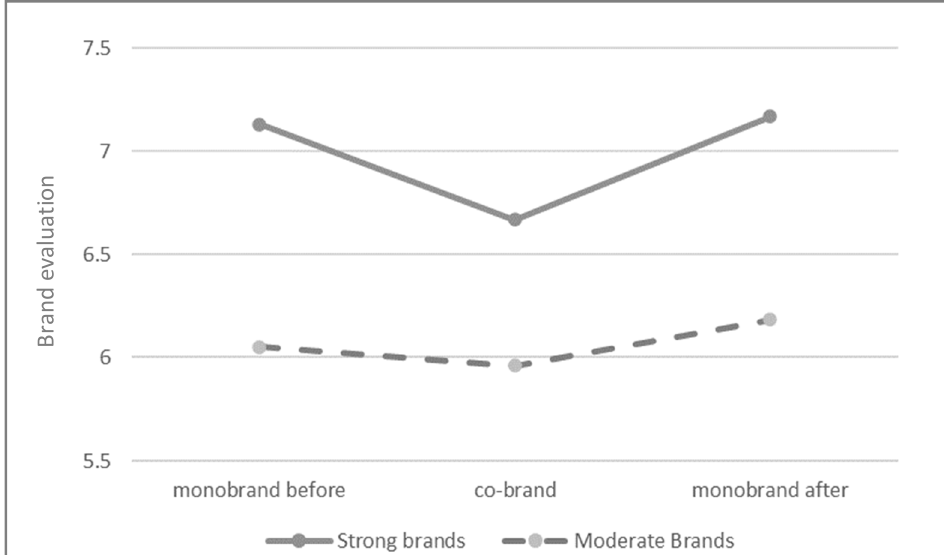
Figure 5. Mean comparisons of study 2.